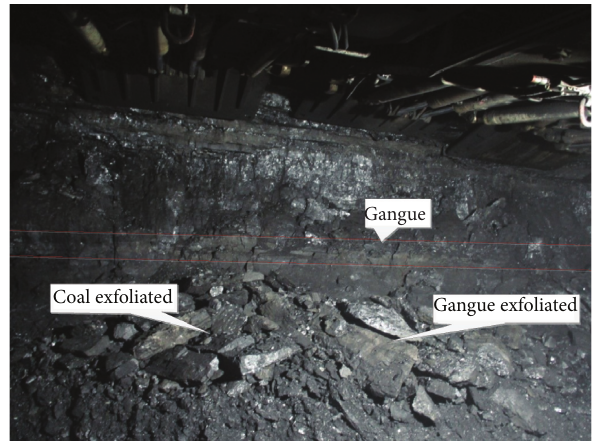
Figure 1: Site map of coal wall spalling in the working